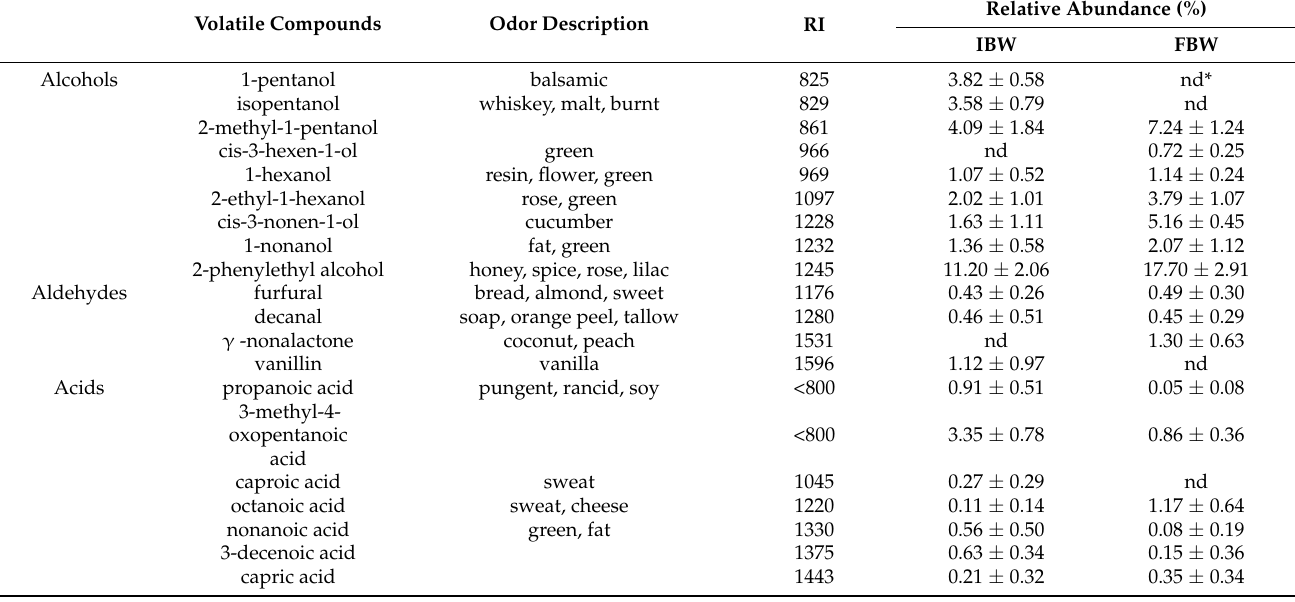
Table 2. Relative abundance of volatile compounds from Chinese bayberry